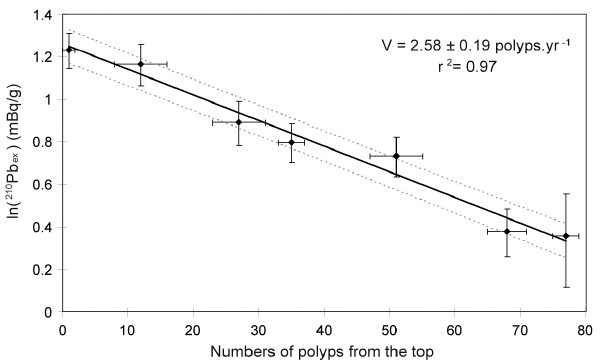
Fig. 8. Age model comparison for the Madrepora oculata spec- imen. Coral 14 C measurements expressed as pMC compared to available seawater 14 C data of dissolved inorganic carbon (see text GEOSECS, TTO and Norwegian research cruise) allow us to iden- tify the bomb 14 C peak with an age for the base of between 37 and 43yr. This estimation is in agreement at 2 σ with that of 210 Pb- 226 Ra method. The dashed line indicates the year of sea surface 14 C bomb